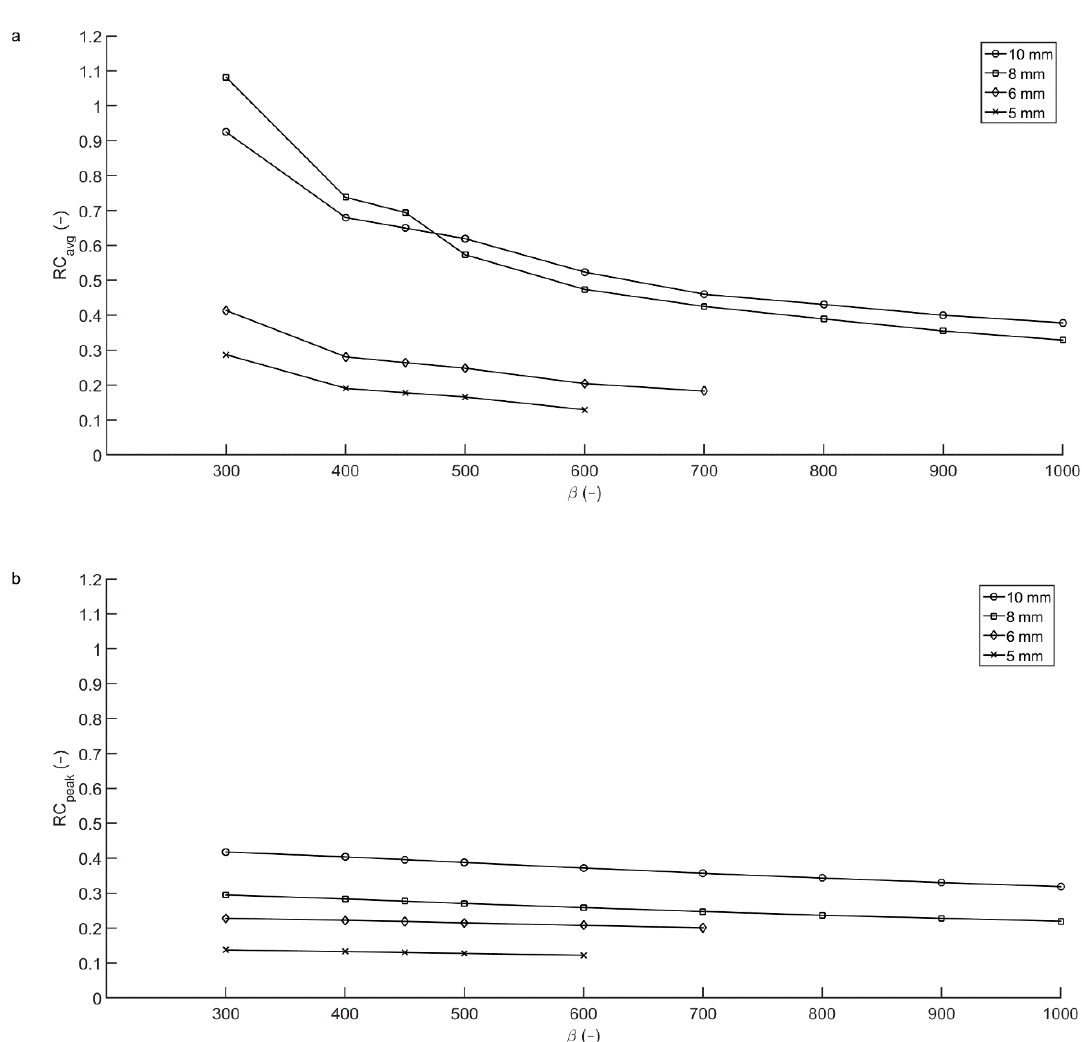
Figure 3. Average and peak recovery coefficients from the Micro Hollow Sphere phantom. For an acquisition time of two minutes per bed position, the apparent RC avg ( a ) of the 8 mm sphere measured with T/B ratio 10:1 exceeds that of the bigger spheres for low β , as the center of this sphere happened to coincide with the center of a voxel. Taking RC peak as a measure for the recovery coefficient ( b ), the recovery coefficients are lower, but more robust.